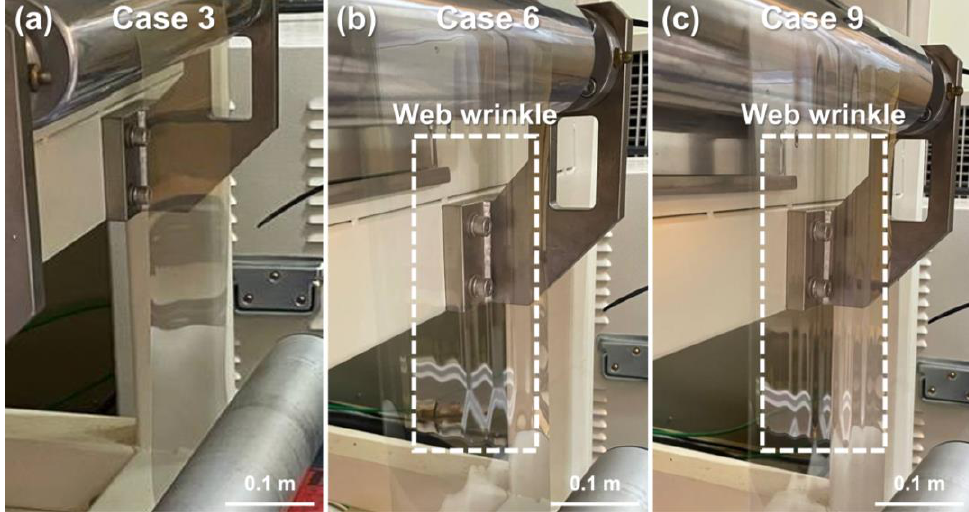
Figure 7. Observed wrinkles caused by strain deviation of web: ( a ) no wrinkles; ( b ) wrinkles due to increased operating speed; ( c ) severe wrinkles.